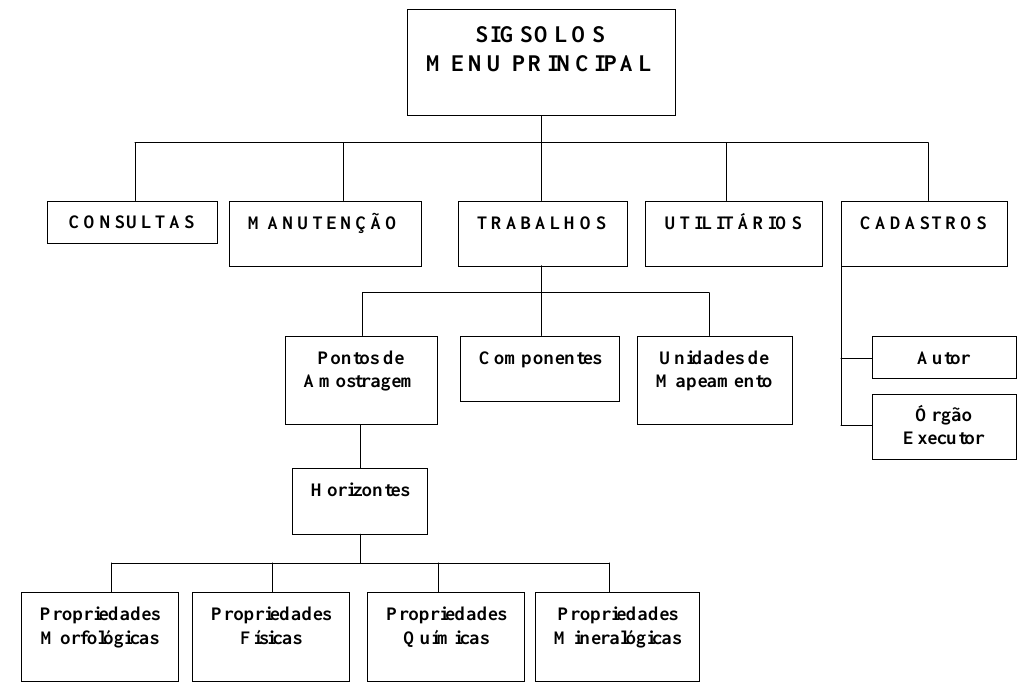
Figura 3. Estrutura hierárquica da funcionalidade da entrada de dados do SigSolos.